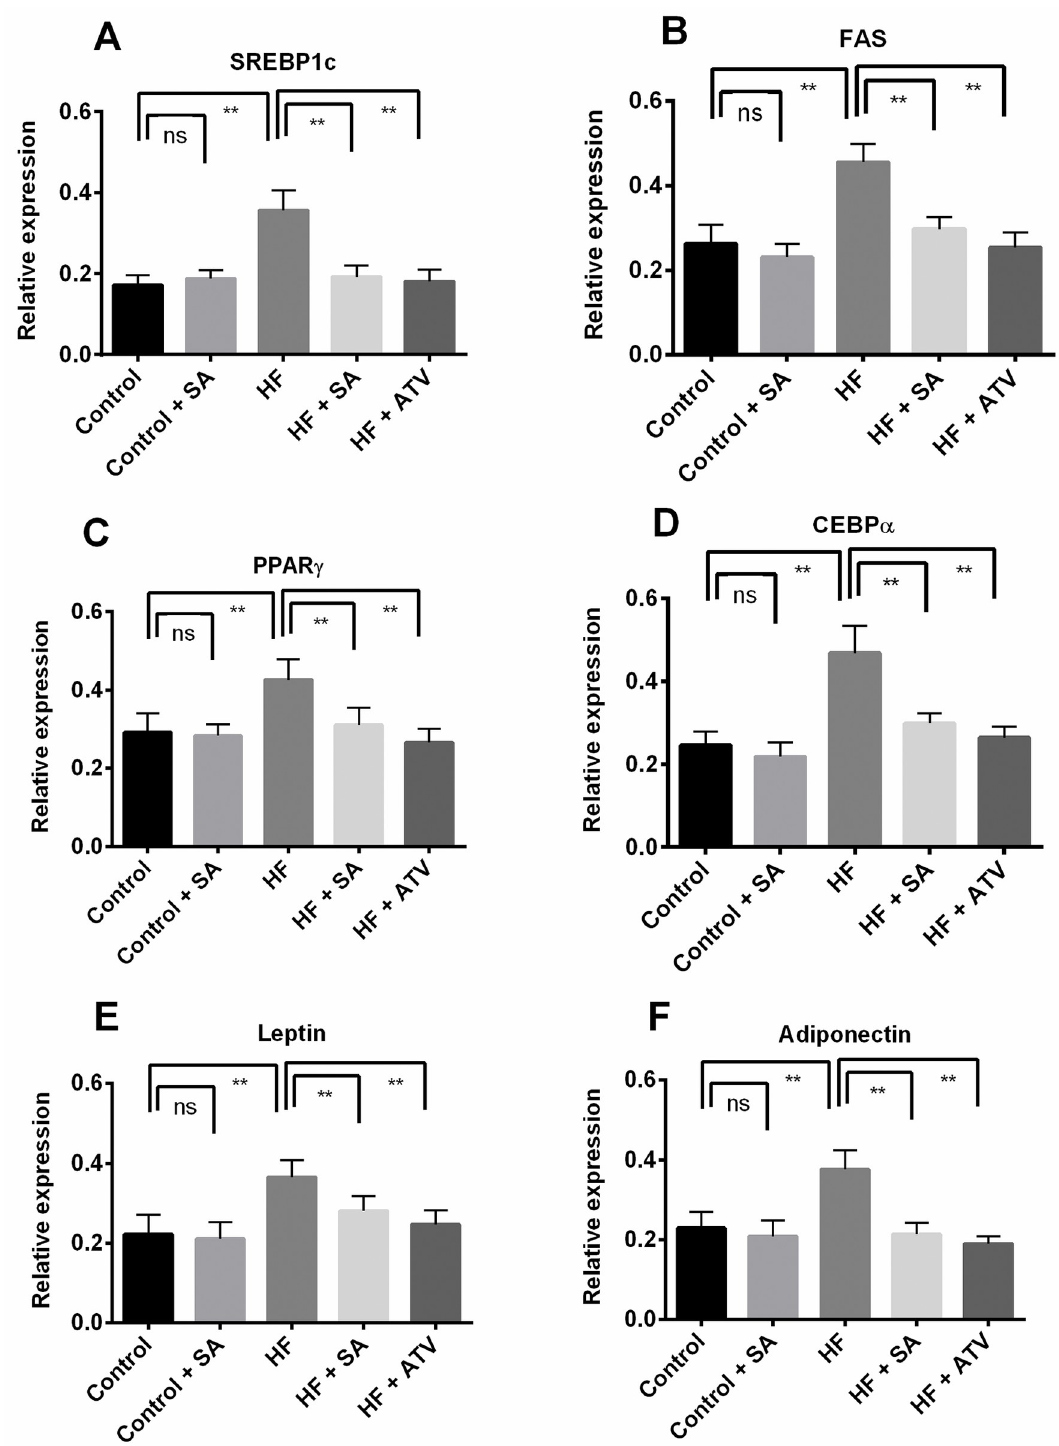
Fig 7. Effect of Senna alexandrina leaf supplementation on Fat metabolizing genes expression in liver of high-fat diet induced obese rats. A. Sterol regulatoryi element binding protein 1c (SREBP1c). B. Fatty acid synthase (FAS). C. Peroxisome proliferator activated receptor (PPAR γ ). D. CCAAT enhancer binding protein alpha (CEBP α ). E. Leptin. F. Adiponectin. Values are presented as mean ± SD, n = 6. One-way ANOVA followed by Tukey’s multiple comparisons test was done for statistical comparison. Values are considered significance at p � 0.05. �� represents p �